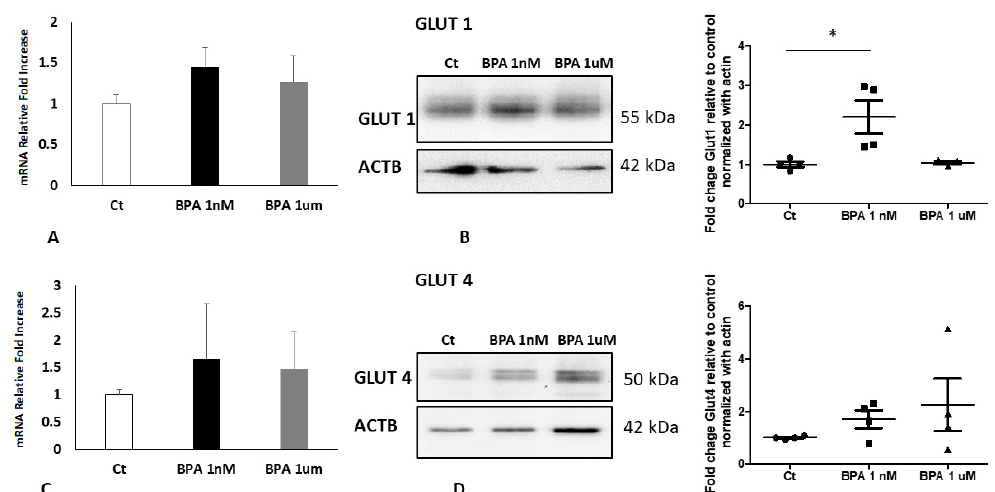
Figure 3. GLUT 1 and 4 expressions ( A , C ) and protein levels ( B , D ) in placenta explants treated with BPA from control pregnancy. ( A ) Fold Change of GLUT1 mRNA in placental explants from NW women ( n = 3) treated with BPA 1 nM and BPA 1 µ M compared to the vehicle as control. ( B ) Representative WB (left panel) and corresponding densitometry (right panel) of GLUT1 in placental explants from NW women ( n = 4) treated with BPA 1 nM and BPA 1 µ M compared to the vehicle as control. ( C ) Fold Change of GLUT4 mRNA in placental explants from NW women ( n = 3) treated with BPA 1 nM and BPA 1 µ M compared to the vehicle as control. ( D ) Representative WB (left panel) and corresponding densitometry (right panel) of GLUT4 in placental explants from NW women ( n = 4) treated with BPA 1 nM and BPA 1 µ M compared to the vehicle as control. Data are presented as mean ± ES. Significance was determined using a one-way ANOVA and Bonferroni’s test for post hoc comparisons * p < 0.05. Ct: control.